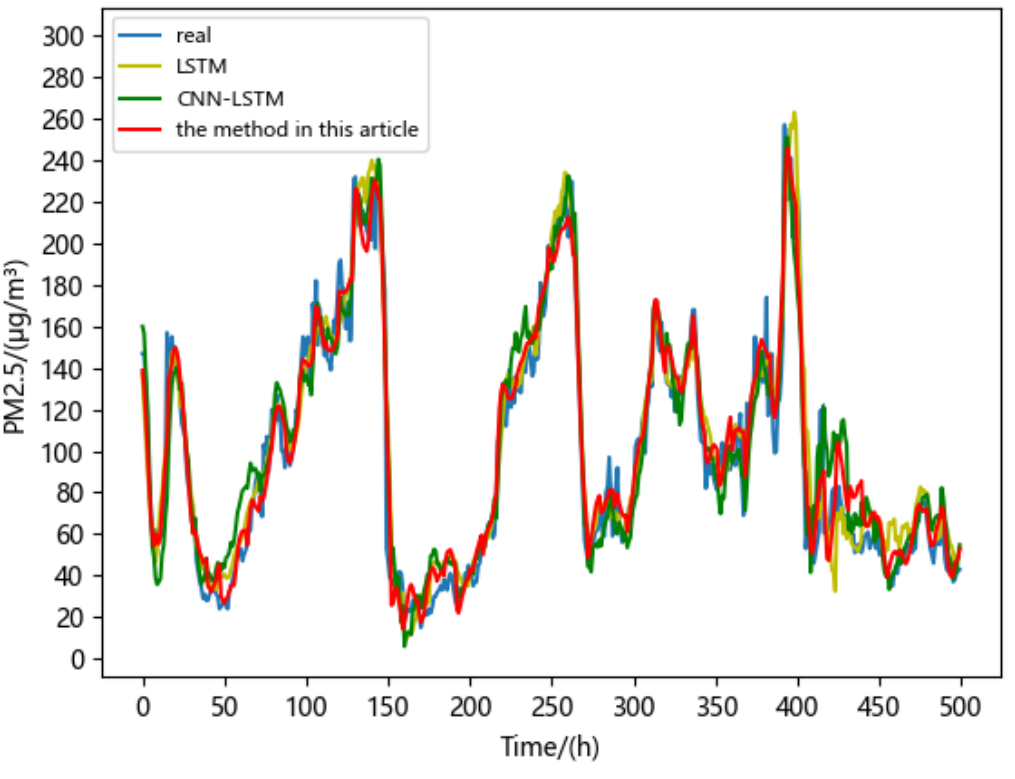
Figure 7. The prediction results of the three methods with a prediction step of 8 h.